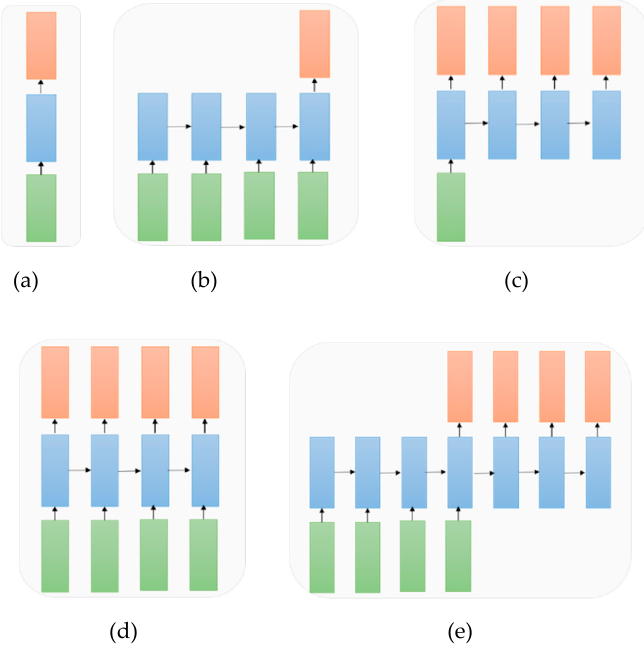
Figure 33. The different structure of RNN with respect to the applications: ( a ) One to one; ( b ) many to one; ( c ) one to many; ( d ) many to many; and ( e ) many to many.